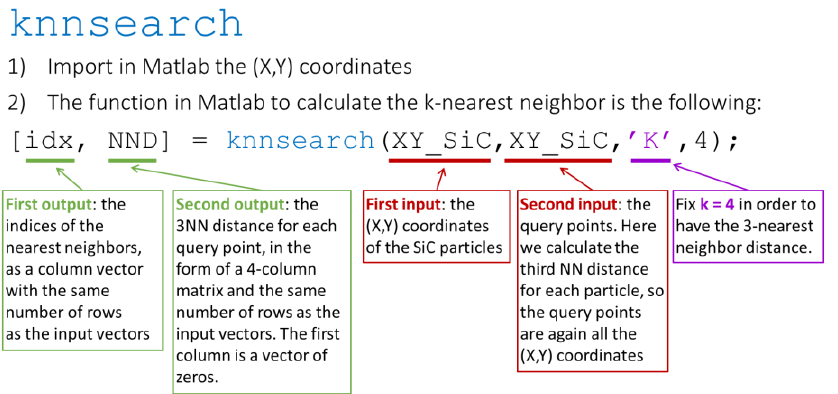
Figure A2. Description of the ‘knnsearch’ Matlab function used to evaluate the third nearest-neighbour (NN) distance.